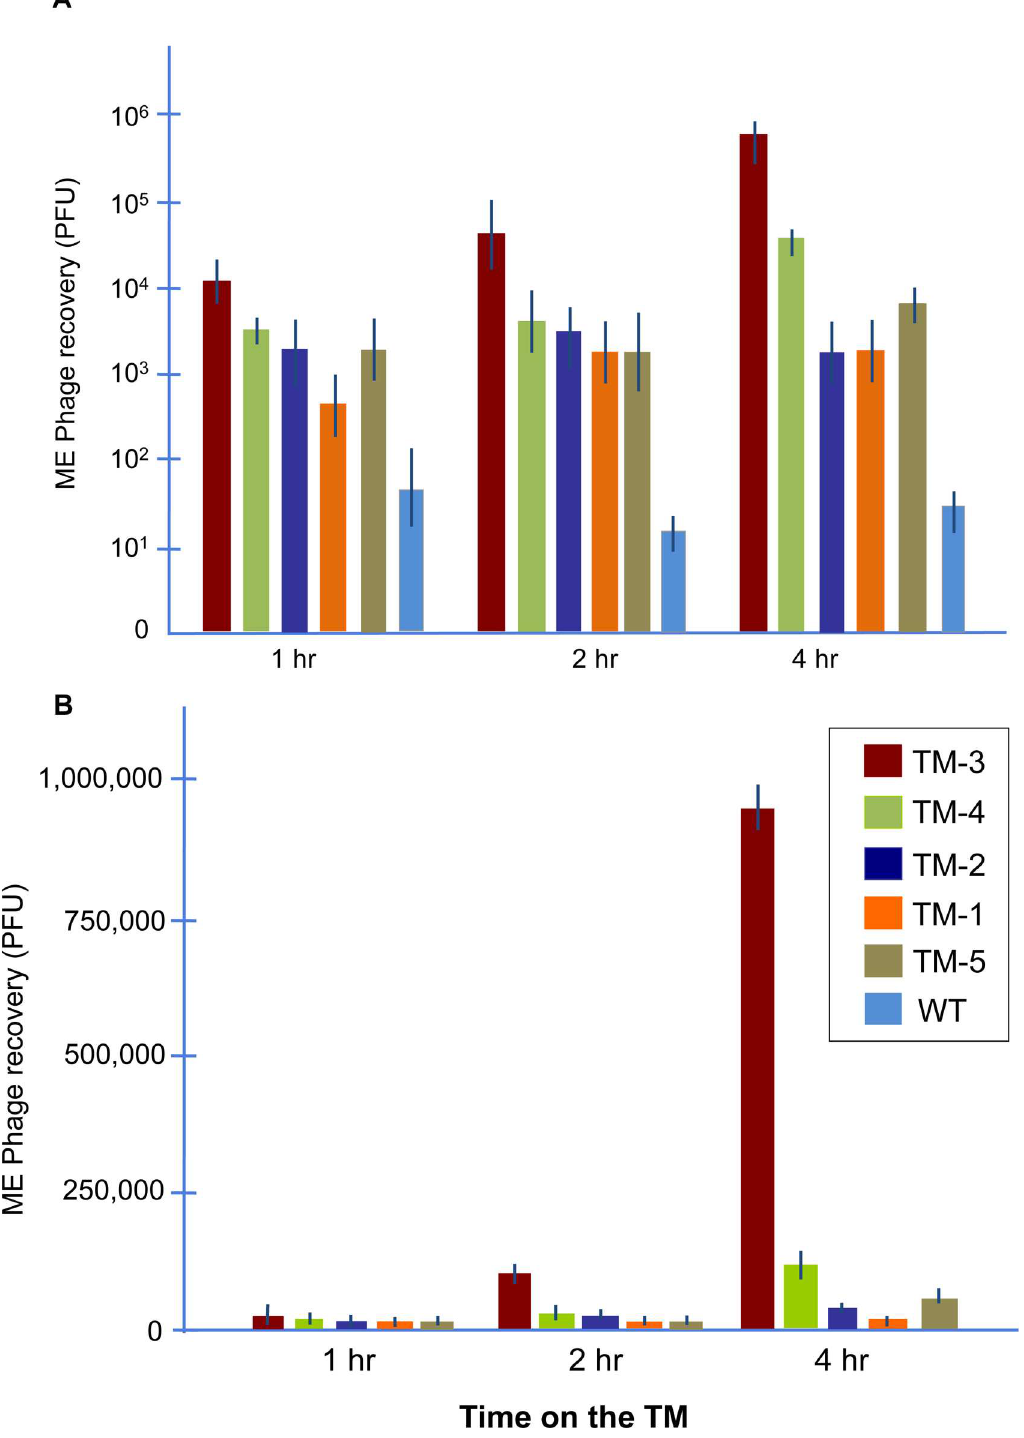
Fig 1. Kinetics of peptide-mediated trans-TM transport. ME recovery kinetics of five TM-transiting peptidephage, comparedto WT phage particles, followingincubationof 10 10 phage on the exterior surface of the TM for 1, 2 or 4 hrs. A = log scale, B = linear scale. All TM-transiting peptidephagewere recovered at levels much higherthan were WT phagenot bearinga peptide. Phage bearingTM-3 peptidewere recoveredat much highertiters (more than 10 5 higher at 4 hrs) than WT phage,and significantly more than any other TM-transiting phage.TM-3 phage also exhibited